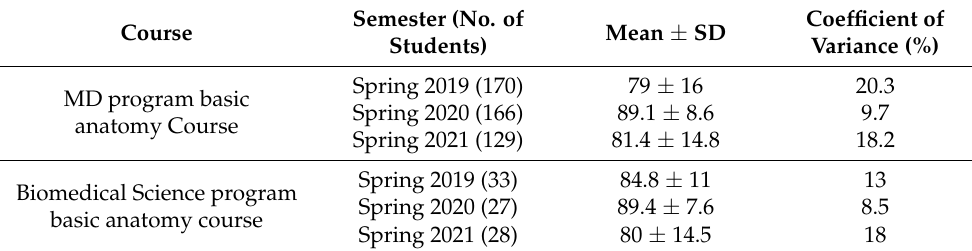
Table 2. Students’ scores in the theoretical component of basic anatomy courses for MD and BMS programs in three different semesters. CV: Coefficient of variance is calculated as SD/Mean × 100.